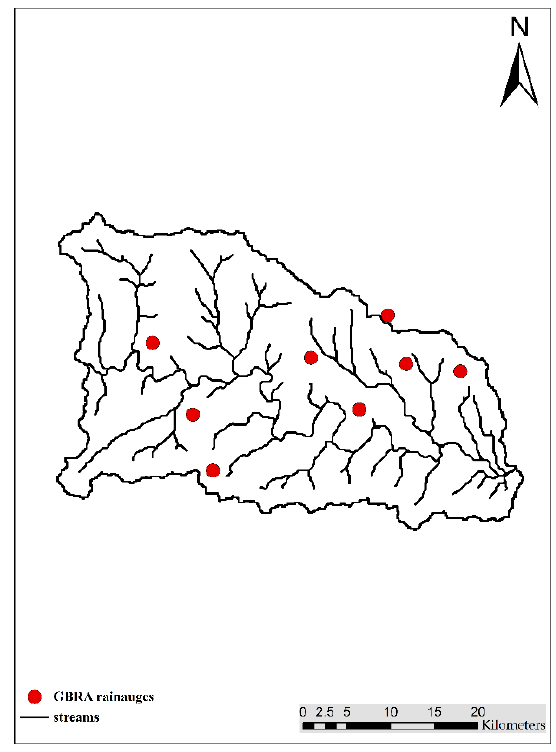
Figure 6. Location of rain gauges in the